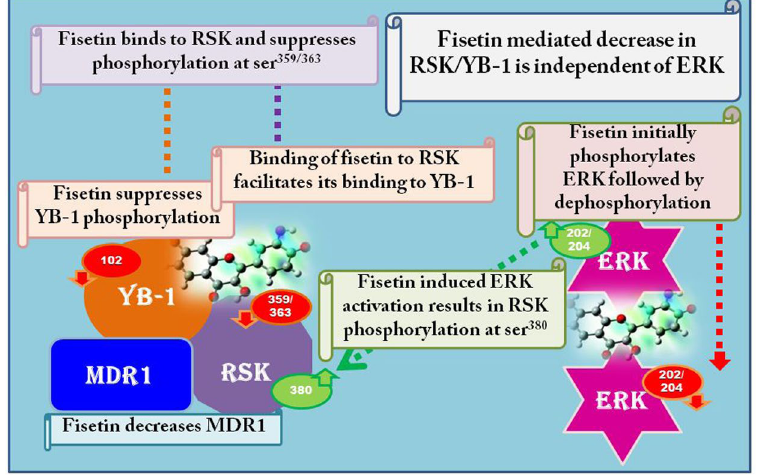
Figure 7. Schematic diagram depicting the proposed mechanism of action of fisetin: SPR studies showed that interaction of fisetin with RSK2 promotes its binding to YB-1. Fisetin mediated downregulation of YB-1/RSK signaling is associated with a decrease in MDR1. Fisetin-treated cells showed an initial increase in ERK1/2 phosphorylation at threonine 202 /tyrosine 204 followed by a sustained decrease, suggestive of a biphasic response. Fisetin mediated decrease in RSK/YB-1 is independent of ERK. Inhibition of ERK did not interfere with RSK phosphorylation at threonine 359 /serine 363 residues in fisetin-treated cells. However, fisetin mediated increase in RSK serine 380 phosphorylation was abrogated with ERK inhibition suggesting that ERK was driving phosphorylation at this